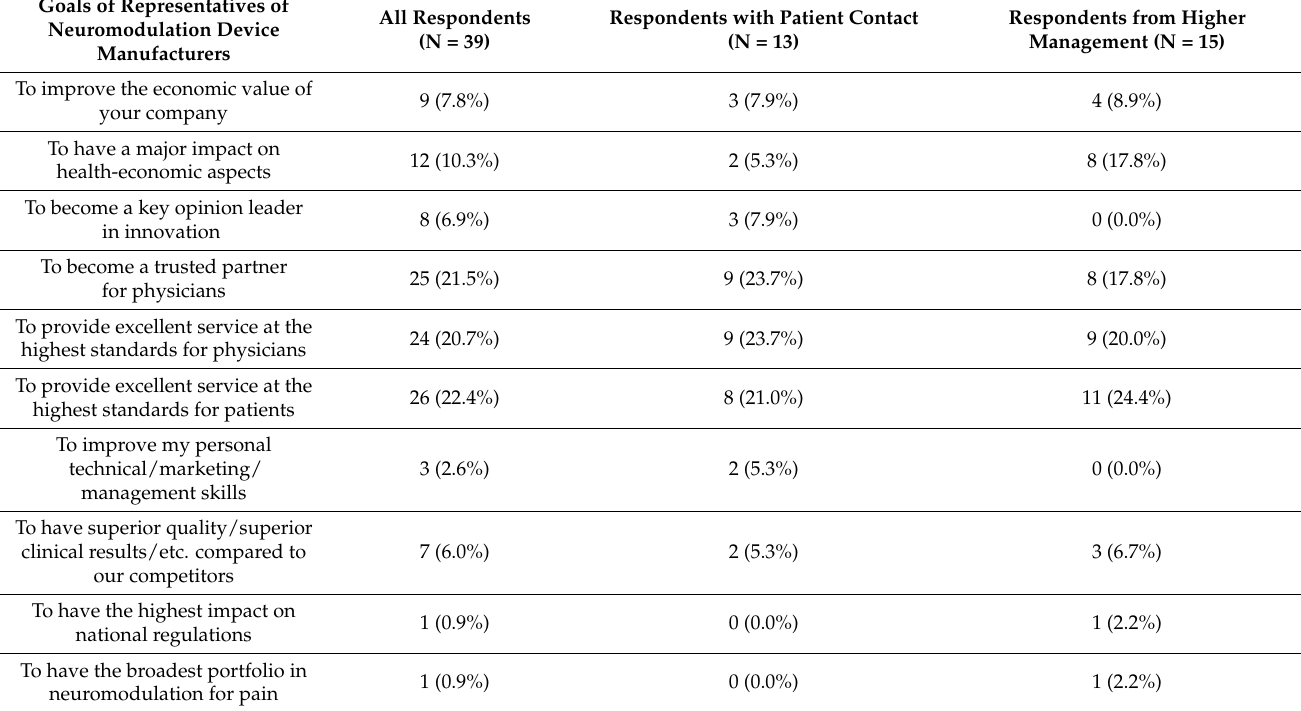
Table 1. Survey respondents reported a total of 116 goals for neuromodulation for pain. The absolute frequency and percentage of the top three goals that were selected by representatives of neuromodulation device manufacturers are presented. Percentages are calculated according to the number of goals that were selected for each group, meaning 116 goals for all respondents, 38 goals for respondent with patient contact, and 45 goals for respondents belonging to higher